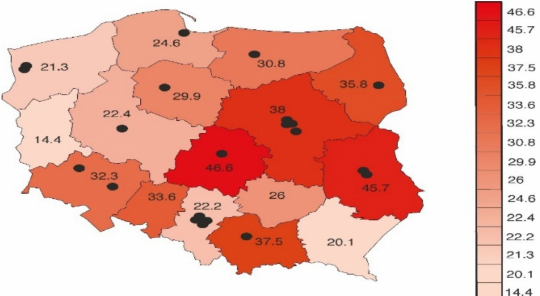
Figure A2. Prevalence of pulmonary arterial hypertension and the numbers of reference pulmonary hypertension centres in di ff erent parts of Poland. The number of black dots corresponds with the number of pulmonary hypertension reference centres in each region of Poland. We did not find any significant correlation between the prevalence of pulmonary arterial hypertension and the number of pulmonary hypertension centers per region ( r = 0.28, p =